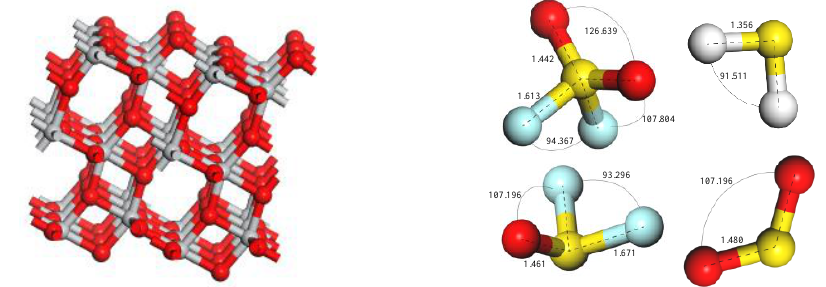
Figure 1 . Perfect crystal model of intrinsic anatase TiO 2 (101) and SO 2 , H 2 S, SOF 2 and SO 2 F 2 gas molecular models, Ti atom is gray, O atom is red, S atom is yellow, F atom is blue, H atom is white.